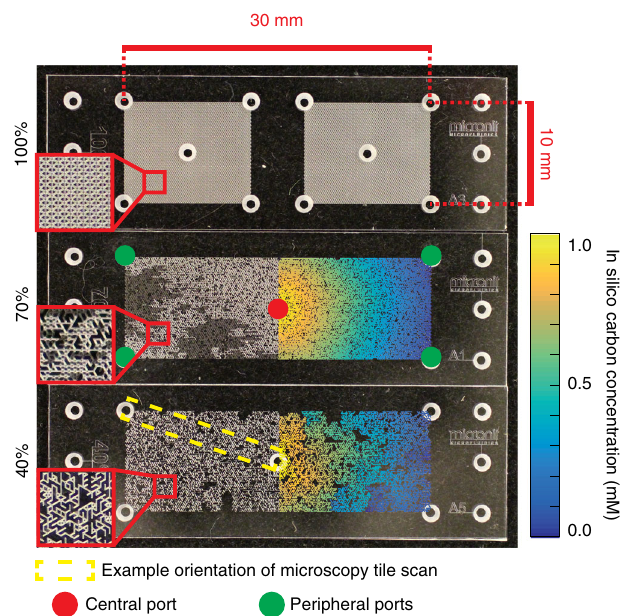
Fig. 2 Images of the micrometric pore networks with varying levels of pore connectivity. The pore network connectivity was systematically reduced by randomly deleting channels (30% and 60% of the channels deleted in the 70% and 40% lattices, respectively) while ensuring that the network remains connected (maintains percolation across opposing sides). Four peripheral ports and one central port allow access to the otherwise hermetically sealed network. Overlaid colored networks show in silico simulated carbon gradients emerging 1 day after bacterial growth with carbon source in the central port and peripheral oxygen (with aerobes and anaerobes present in the network). The network geometry exerts a signi fi cant in fl uence on network-wide concentration fi elds as shown with the overlaid carbon concentration. Microscopy images of the glass-etched micromodels with inoculated bacterial cells were taken from the central to a peripheral port (dashed yellow